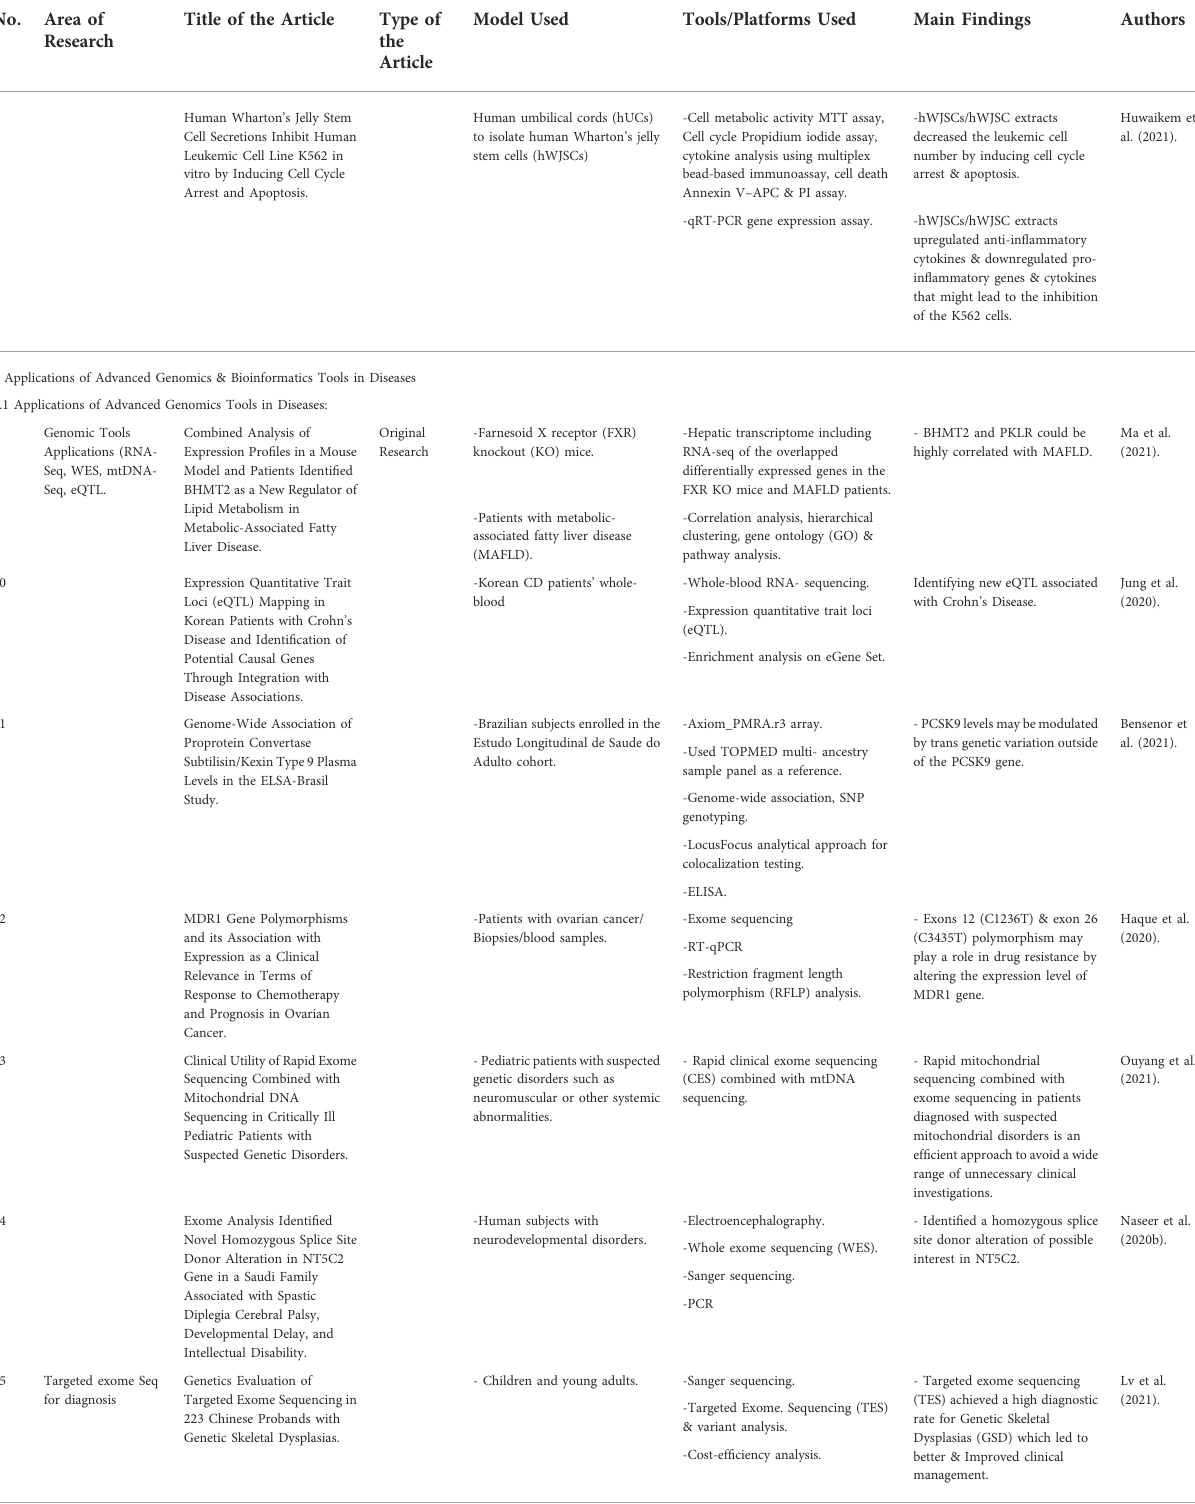
Genetics Evaluation of